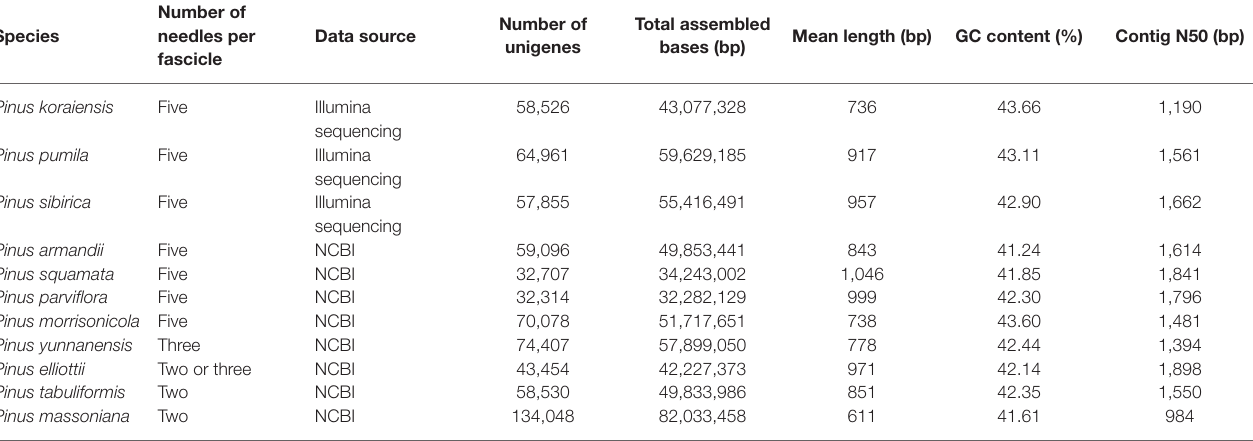
TABLE 2 | Transcriptome sequences from 11 Pinus